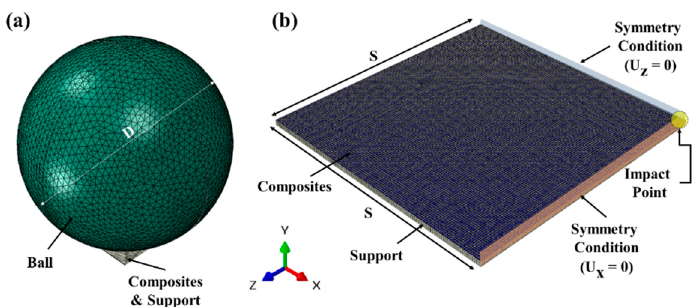
Figure 2. The geometry of the full model for drop test simulation. ( a ) Geometry of the full model, the diameter of the ball (D) = 25 mm; ( b ) composite and support geometry of the quarter model, the length of square composites (S) = 10 mm.